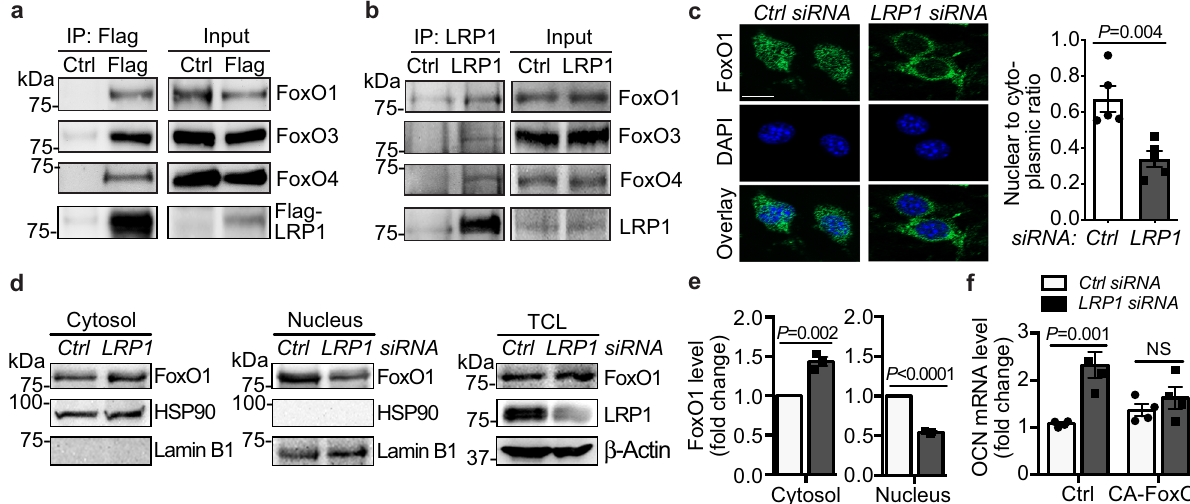
Fig. 3 LRP1 depletion induces OCN through increasing FoxO nuclear export in ECs. a , b LRP1 was associated with FoxOs. Lysates of HEK 293 cells containing stably expressed Flag-LRP1 β ( a ) or MLECs ( b ) were immunoprecipitated with anti-Flag or anti-LRP1 resin and blotted for FoxOs. c – e LRP1 depletion in MLECs led to FoxO1 nuclear export. MLECs were transfected with LRP1 or control siRNAs and subjected for immuno fl uorescence imaging ( b ) or subcellular fractionation assays ( d , e ). MLECs were stained for FoxO1 (green) and the nucleus (DAPI, blue, b ) and the intensity ratio of FoxO1 signals in the nucleus compared to that in cytosol was quanti fi ed. Scale bar, 10 μ m. TCL, total cell lysates. f Constitutively active FoxO1 (CA-FoxO1) inhibited